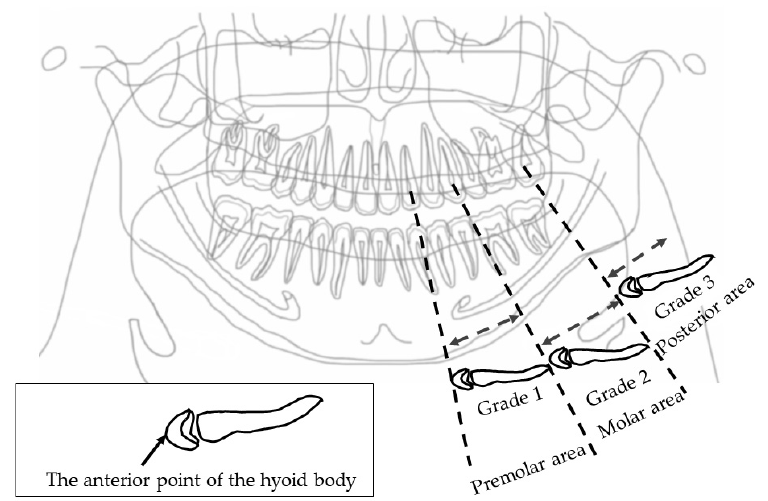
Figure 3. Horizontal hyoid bone position. The horizontal hyoid bone position was graded by the position of the anterior point of the hyoid body.